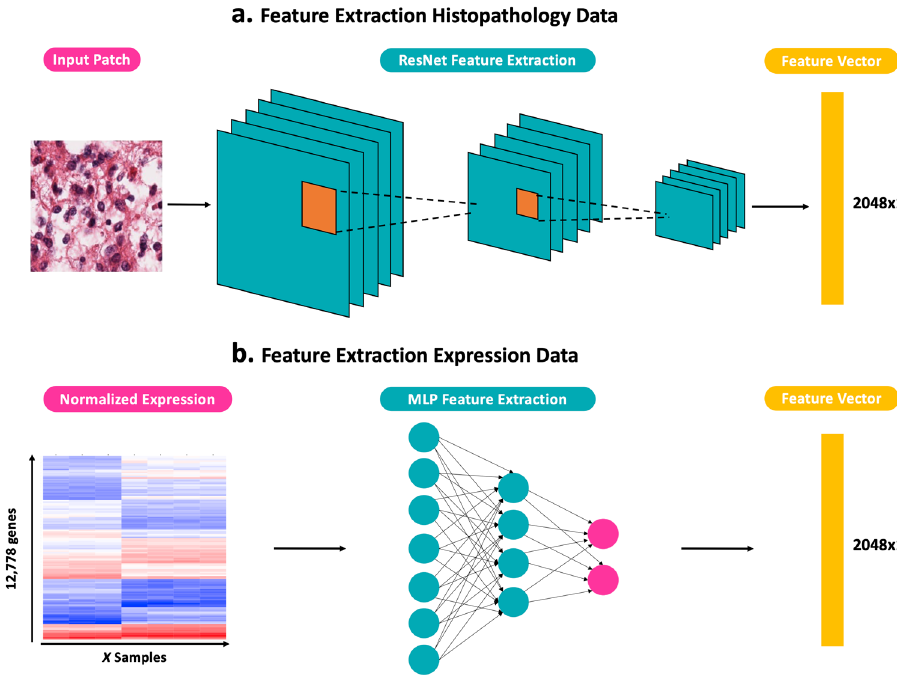
Fig. 2 Feature extraction and survival prediction for histopathological and expression data. a ResNet-50 feature extraction fl ow for pathology image patches. b Multi-Layer Perceptron (MLP) feature extraction fl ow for gene expression data. Both extraction fl ows produce a modality-speci fi c feature vector of dimension 2048 ×